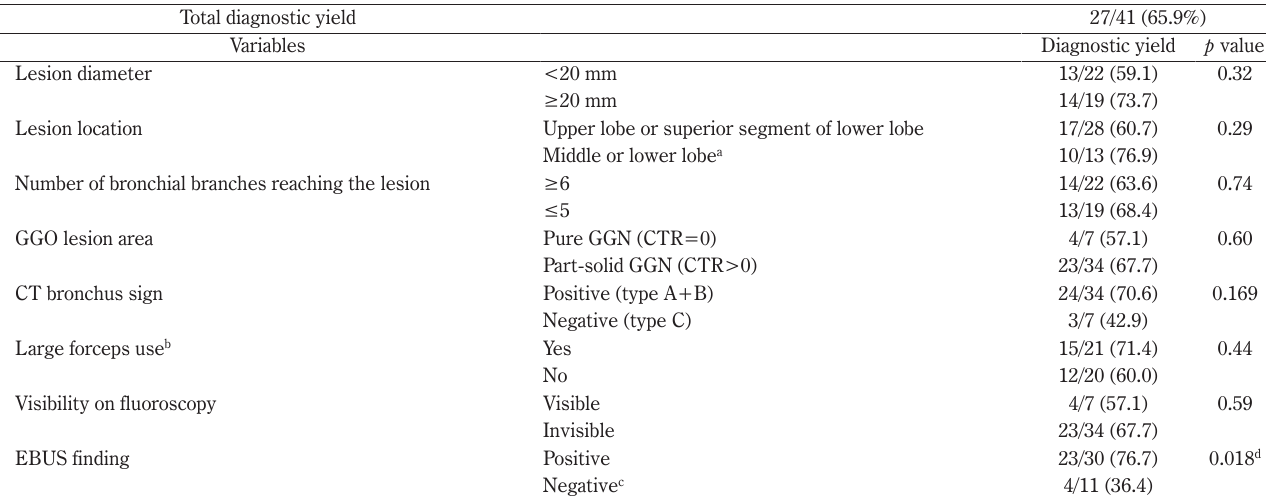
Table 3 Contribution of clinical factors to diagnostic